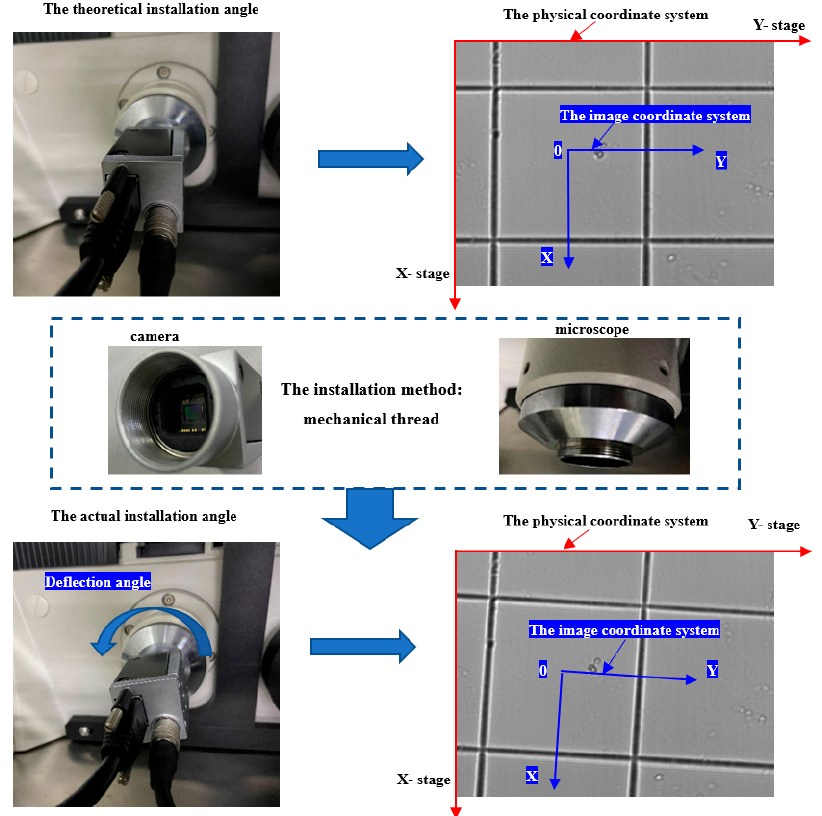
Figure 4. Deviation of the image coordinate caused by camera deflection angle. The camera is connected with the microscope by mechanical threaded. This installation method is easy to produce a deflection angle which is expressed as a clear deviation between the image coordinate system and the physical coordinate system.